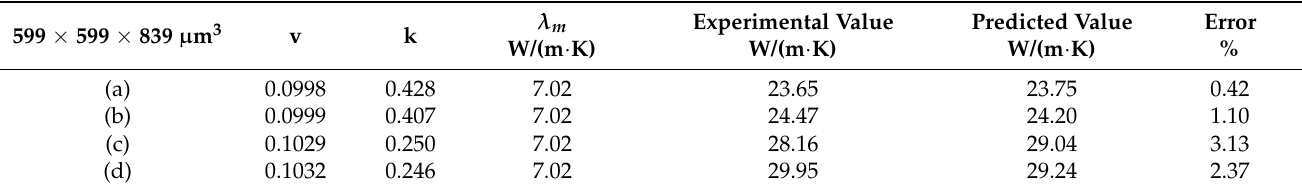
Table 4. The comparison of experimental values and predicted values of literature